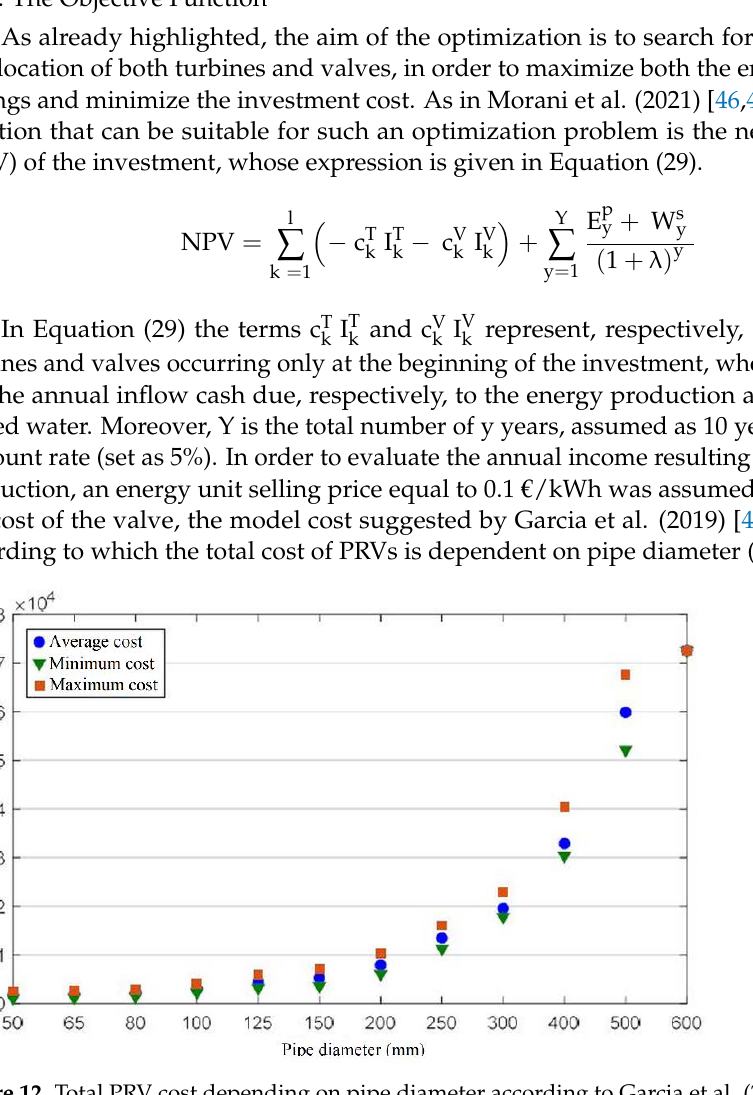
Figure 13. Unit cost per rated power of PATs and conventional turbines coupled to generators [50], compared to other literature cost models [51–54] . With regard to the annual income due to water saving ( W ys ) in Equation (29), it was evaluated as the difference between the total volume of water leaked without and in pres- ence of devices within the network [46,48]: W ys = c w � Q l0 Δ t d − Q lS �